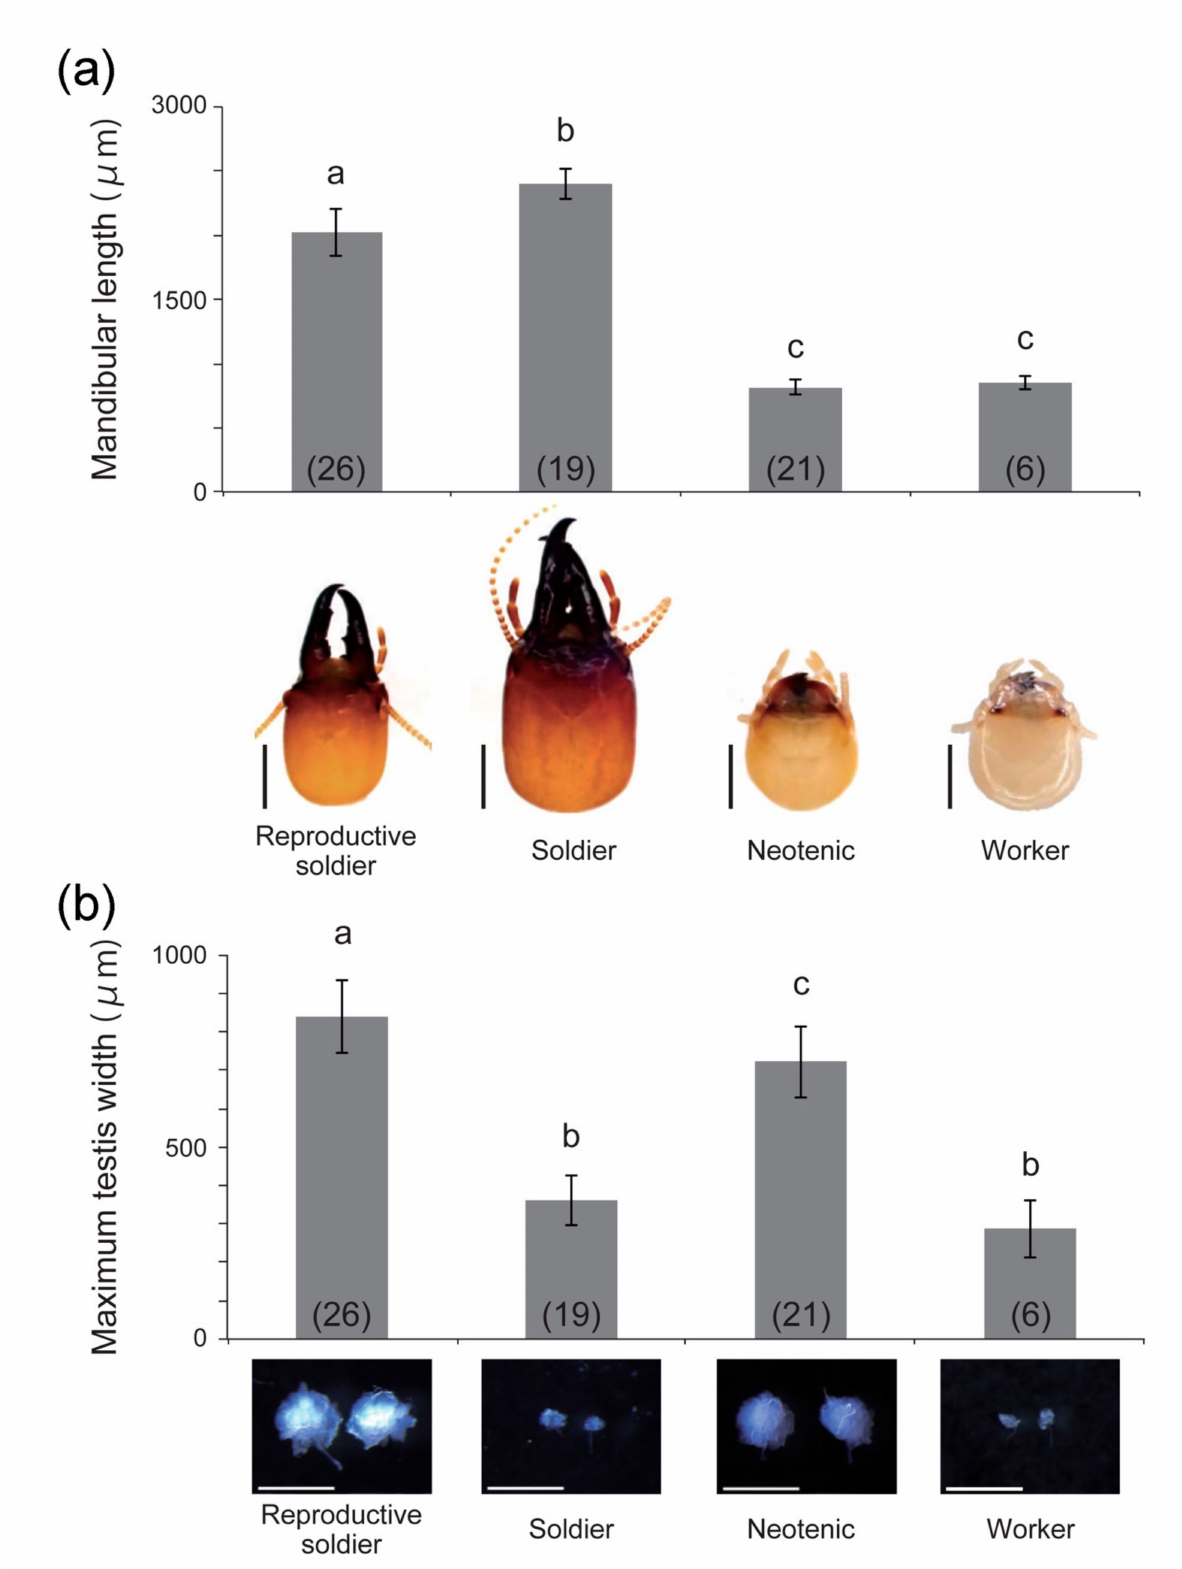
Figure 3. Left mandible ( a ) and testis ( b ) sizes (mean ± S.D.) of each male caste (n = 6–26). The bottom photographs show the head capsule of each caste ( a ) and the testes dissected from individuals ( b ). The numbers of individuals examined are indicated in parentheses. Different letters above the bars denote significant differences (One-way ANOVA followed by Tukey–Kramer test, p < 0.05). Scale bars indicate 1 mm ( a ) and 500 µ m ( b